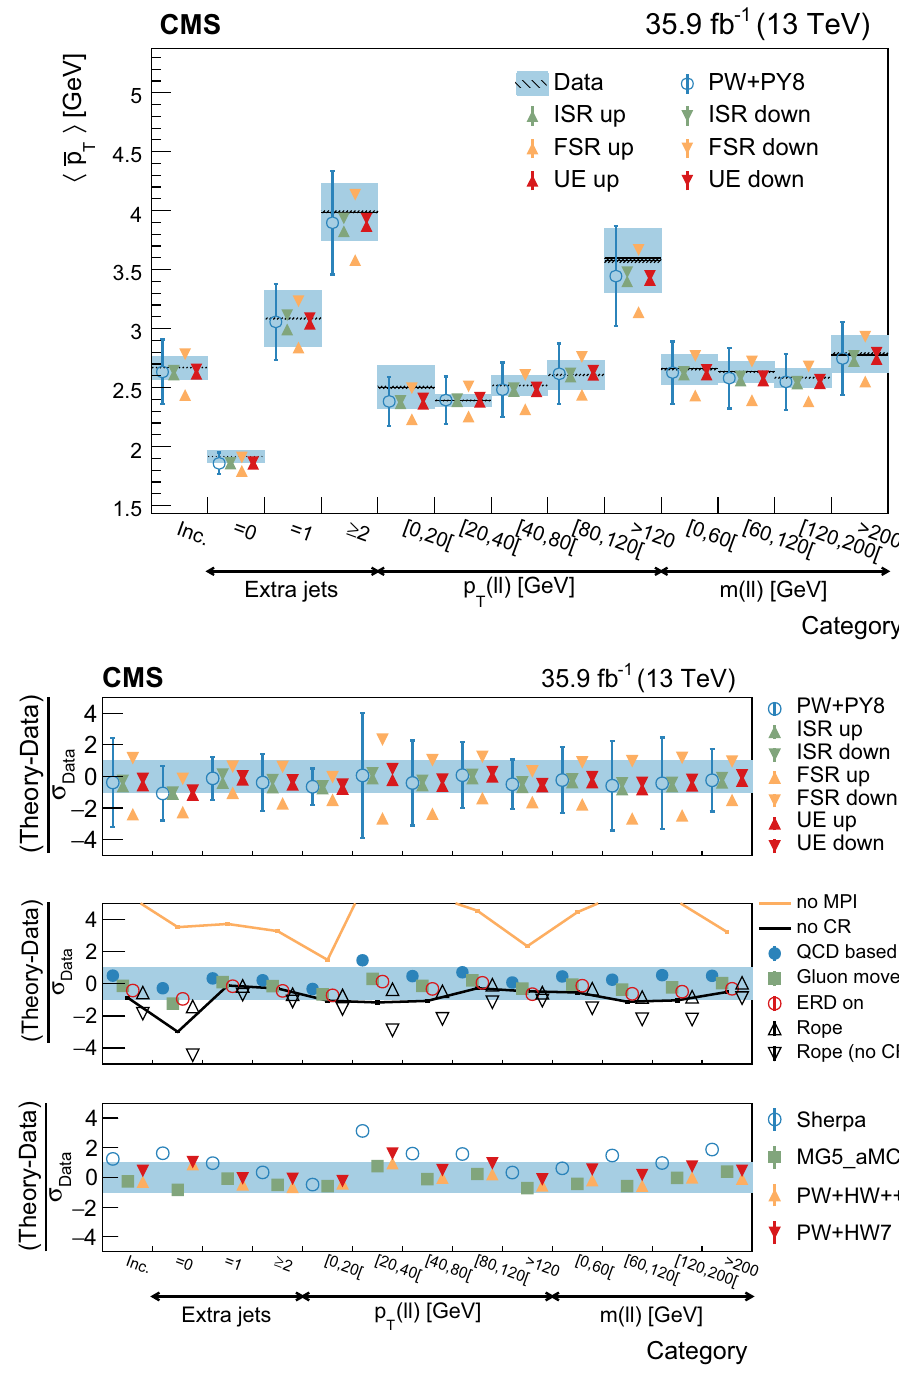
Fig. 17 Average p T in different categories. The conventions of Fig. 14 are